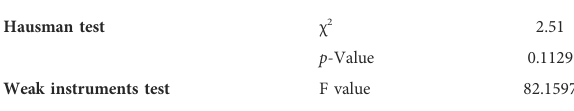
TABLE 6 Endogeneity and weak instruments